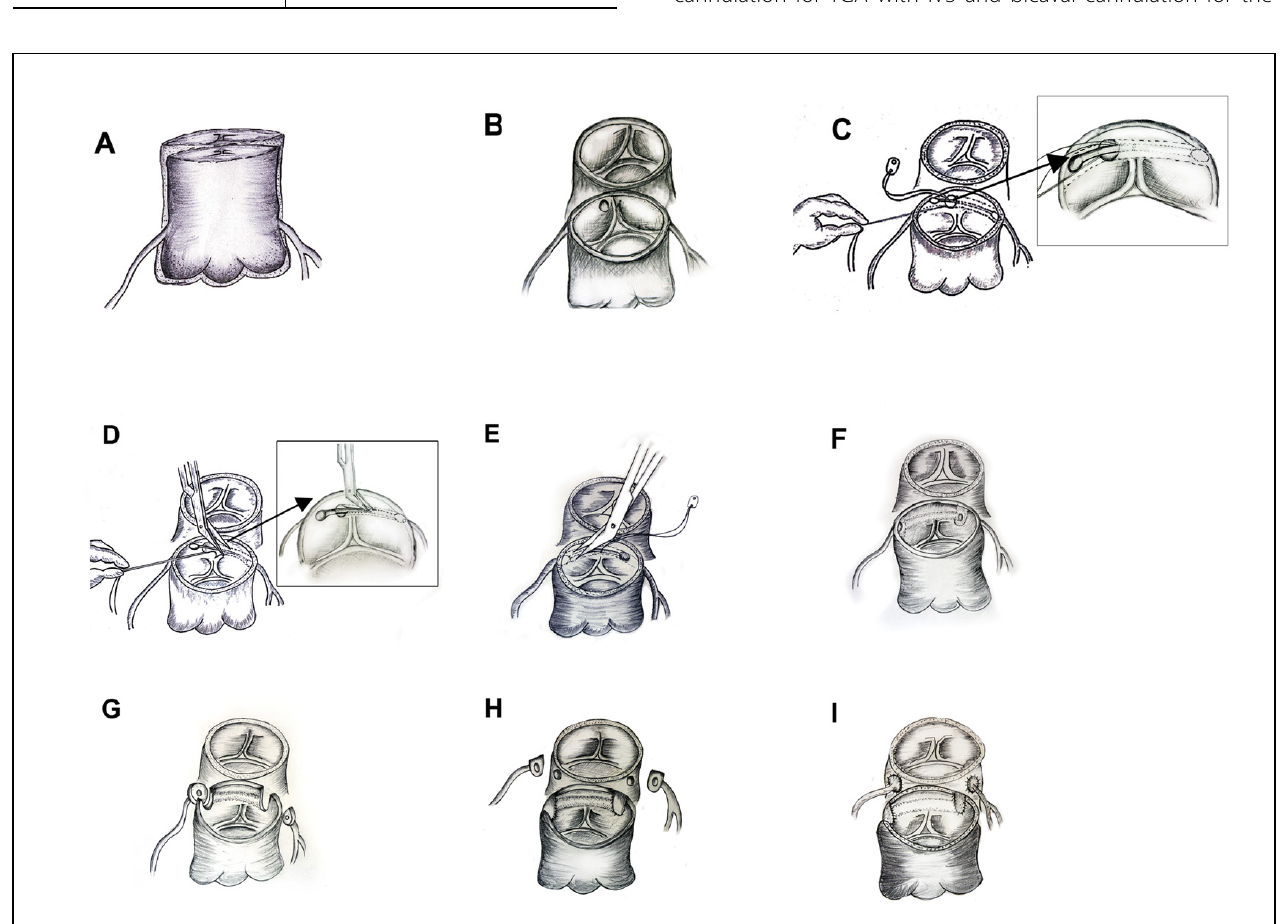
Fig. 2 – Anatomical patterns of the coronary